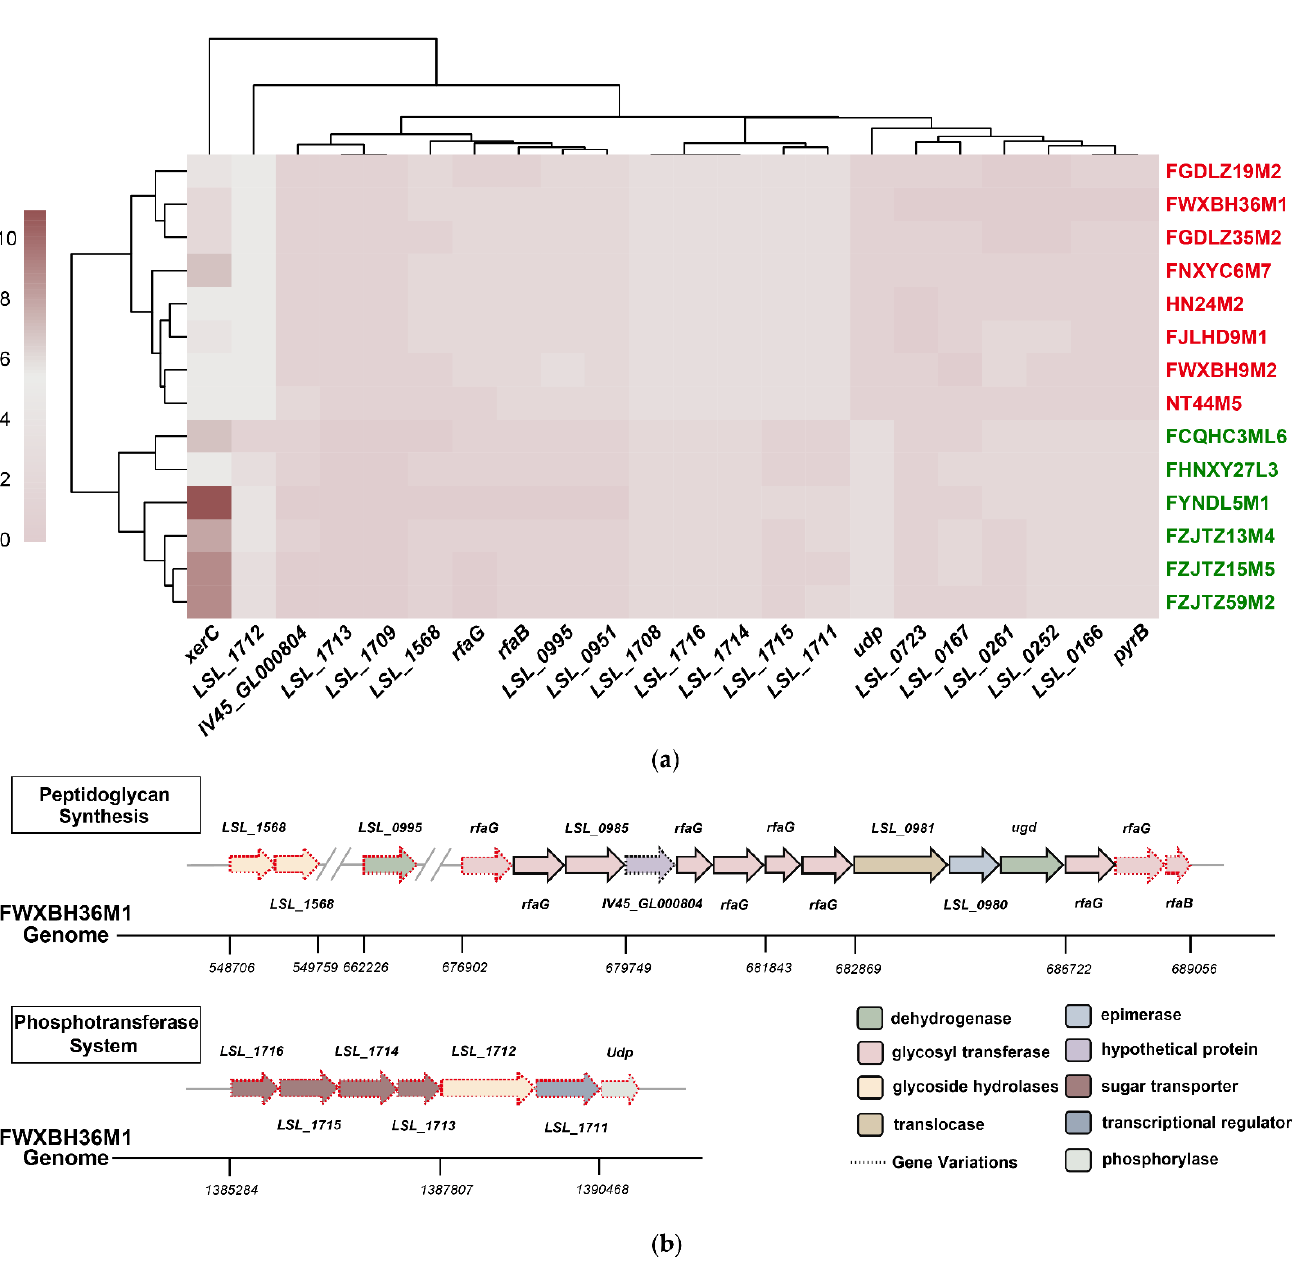
Figure 3. Comparative genomic analysis of 14 L. salivarius strains. ( a ) Differences in gene copy numbers in two groups of L. salivarius strains. Strain names in red represent strains with survival rates higher than 9.5%; strain names in green represent strains with survival rates lower than 0.7%. The algorithm of hierarchical clustering was applied based on the Euclidean distance; ( b ) Two gene clusters of functional genes in FWXBH36M1. Red frames mean genes are related to the mentioned pathway.